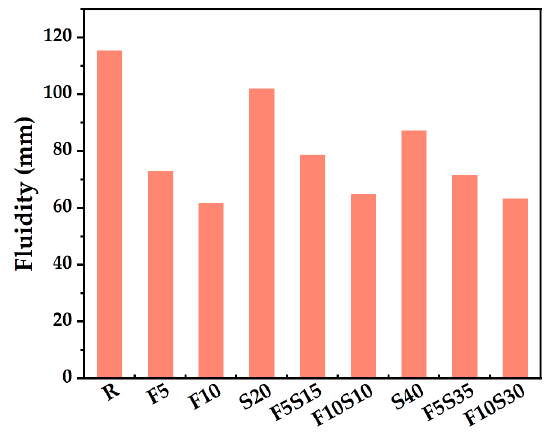
Figure 8. Effect of binder compositions on the fluidity.